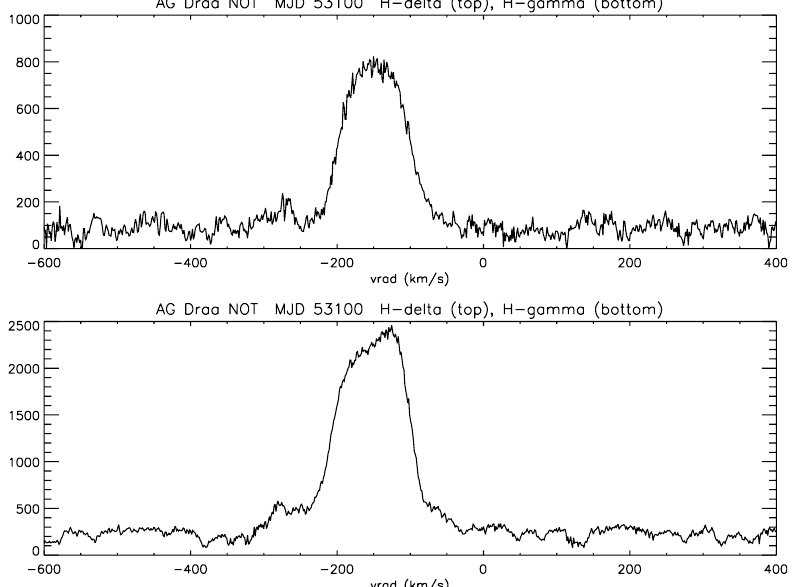
Fig. 5b. The Balmer H γ and H δ line profiles from the NOT spectrum on JD 53100, at orbital phase 0. p